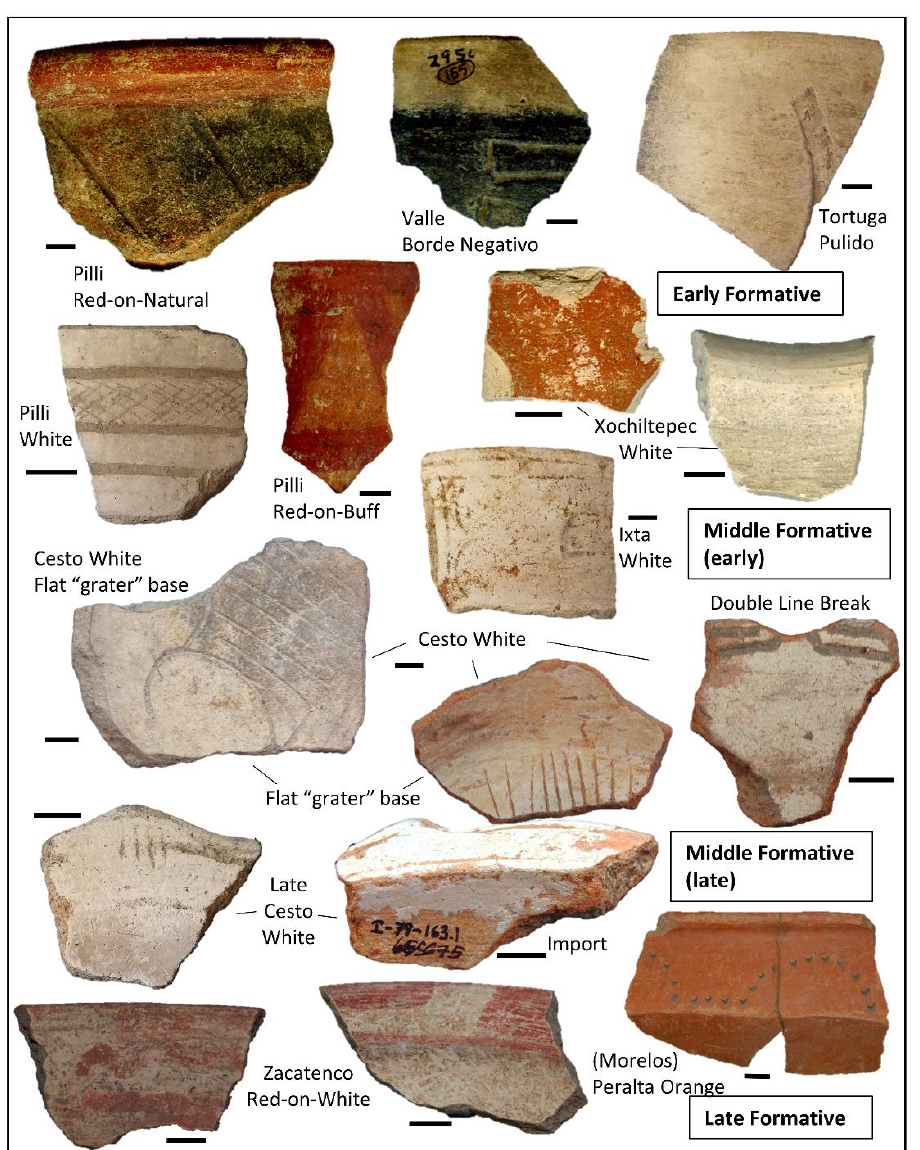
Figure 2. Sample of ceramics in the larger compositional analysis sorted from oldest (top) to youngest (bottom). Scale bar = 1 cm.